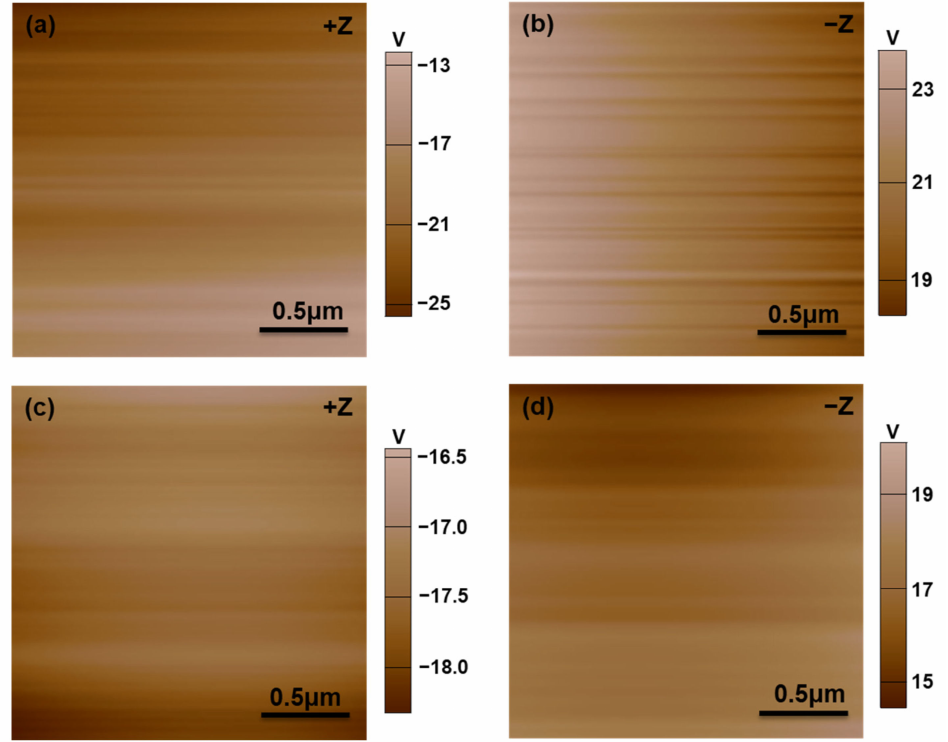
Figure 3. KPFM surface potential images of the LiNbO 3 substrates ( a , b ) before the heating pretreat- ment and ( c , d ) right after the heating